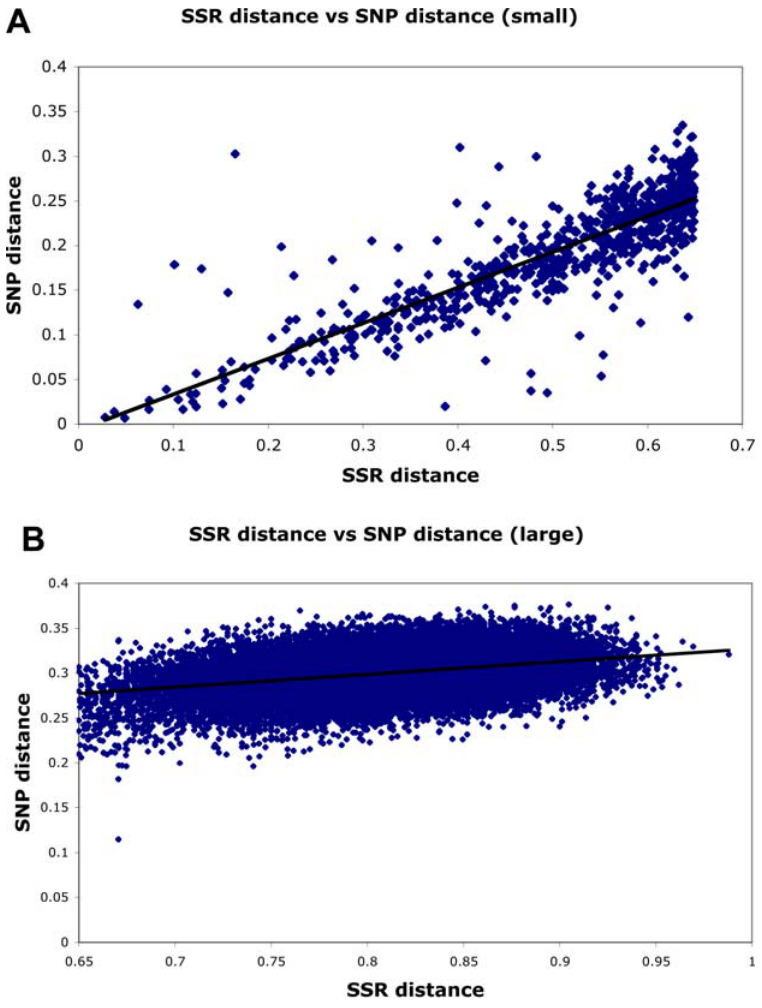
Figure 4. Correlation between genetic distance based on SSRs and SNPs. Each point represents the genetic distance between a pair of individuals, based on sharing of SSR (x axis) or SNP (y axis) alleles. The top panel shows the relationship for pairs of individuals whose SSR distance is , 0.65; the bottom panel shows the relationship for pairs of individuals whose SSR distance is $ 0.65.